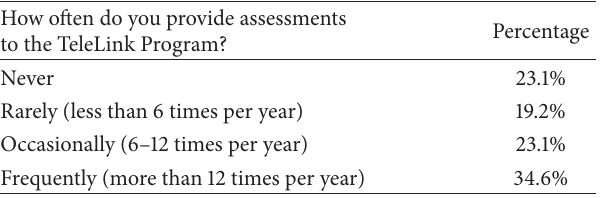
Table 1: Frequency of assessments ( 𝑛 = 26 ).